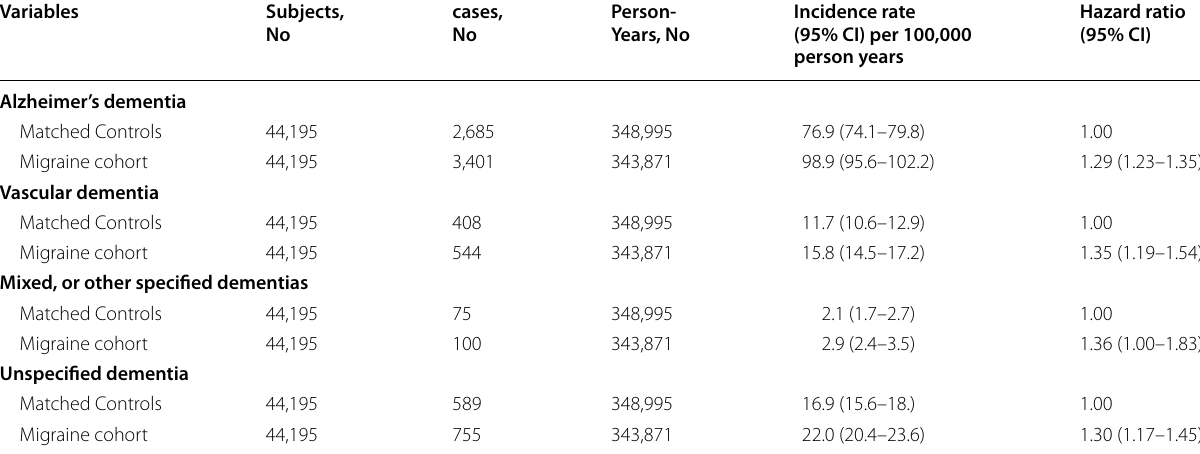
Table 3 Risk of each type of dementia in the migraine cohort and matched controls